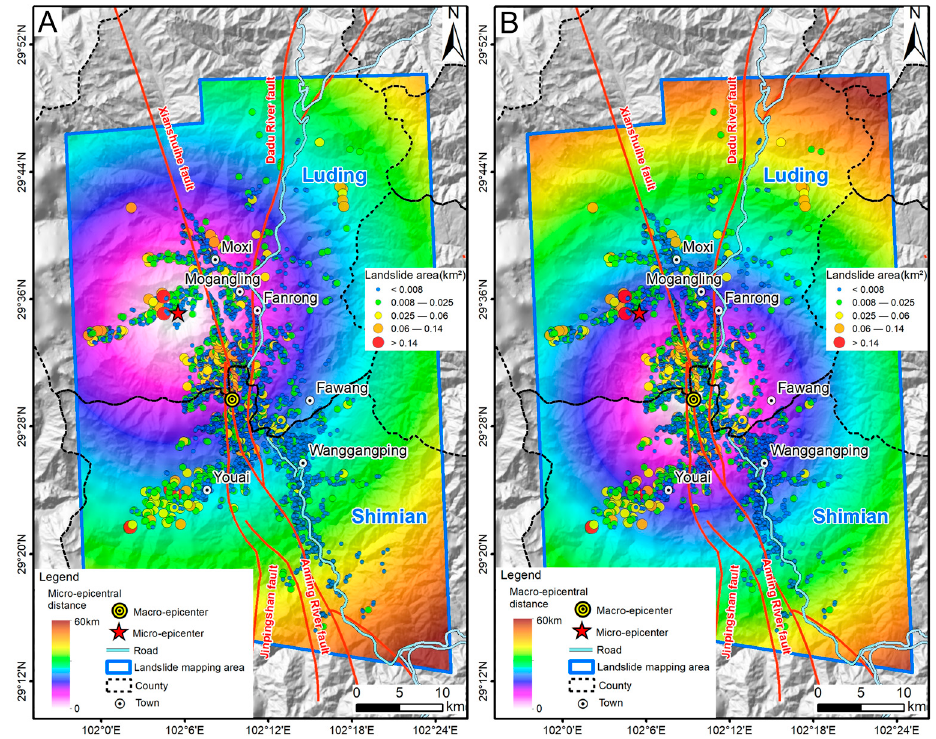
Figure 7. Coseismic landslide distribution with epicentral distance. ( A ) micro-epicenter; ( B ) macro-epicenter.